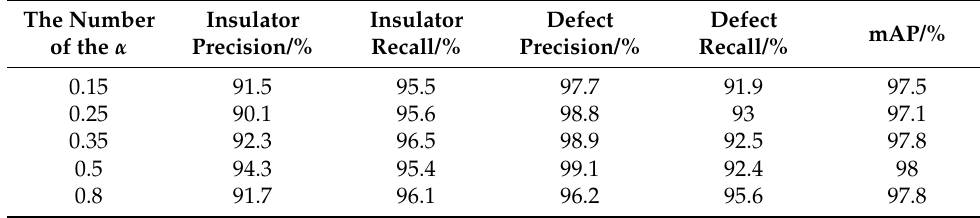
Table 5. Comparison of weighted results for different α